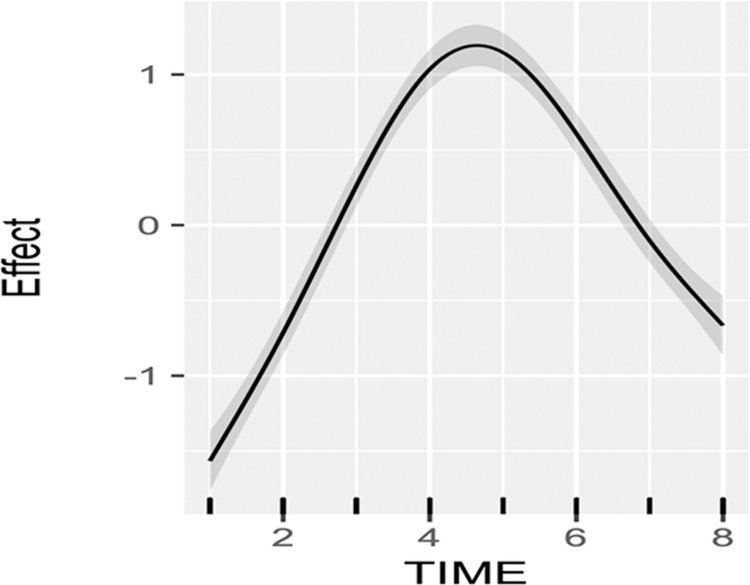
Normalized smooth pupil dilation function (“Effect”, ordinate, normalized mm) versus time (seconds) derived from a generalized additive model with time, sex, and stimulus intensity and type predictor variables.The grey region around the solid line is the approximate 95% confidence interval.